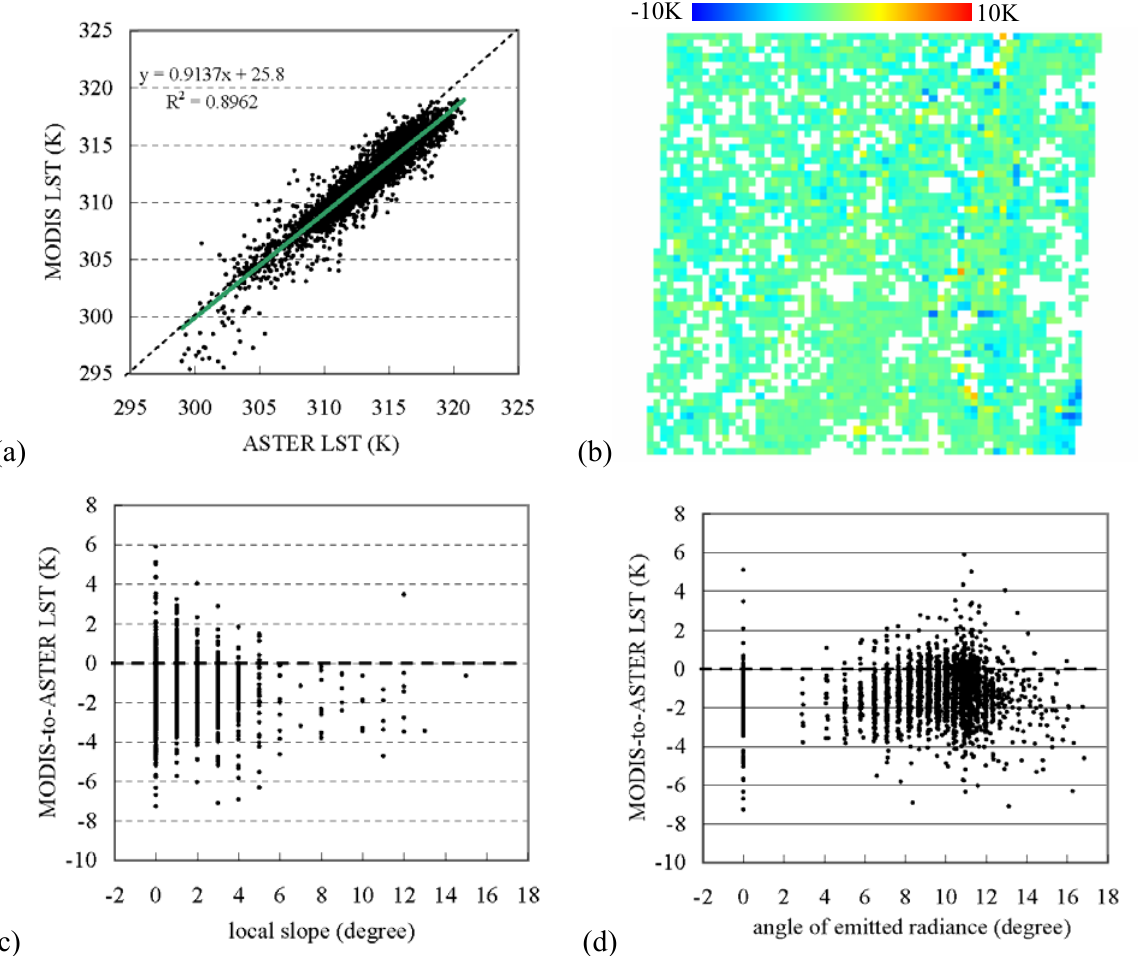
Figure 4 . (a) ASTER LST versus the rectified MODIS LST, (b) spatial distribution of ASTER-to-MODIS LST discrepancy, (c) local slope versus ASTER-to-rectified MODIS LST, and (d) angle of emitted radiance versus ASTER-to-rectified MODIS